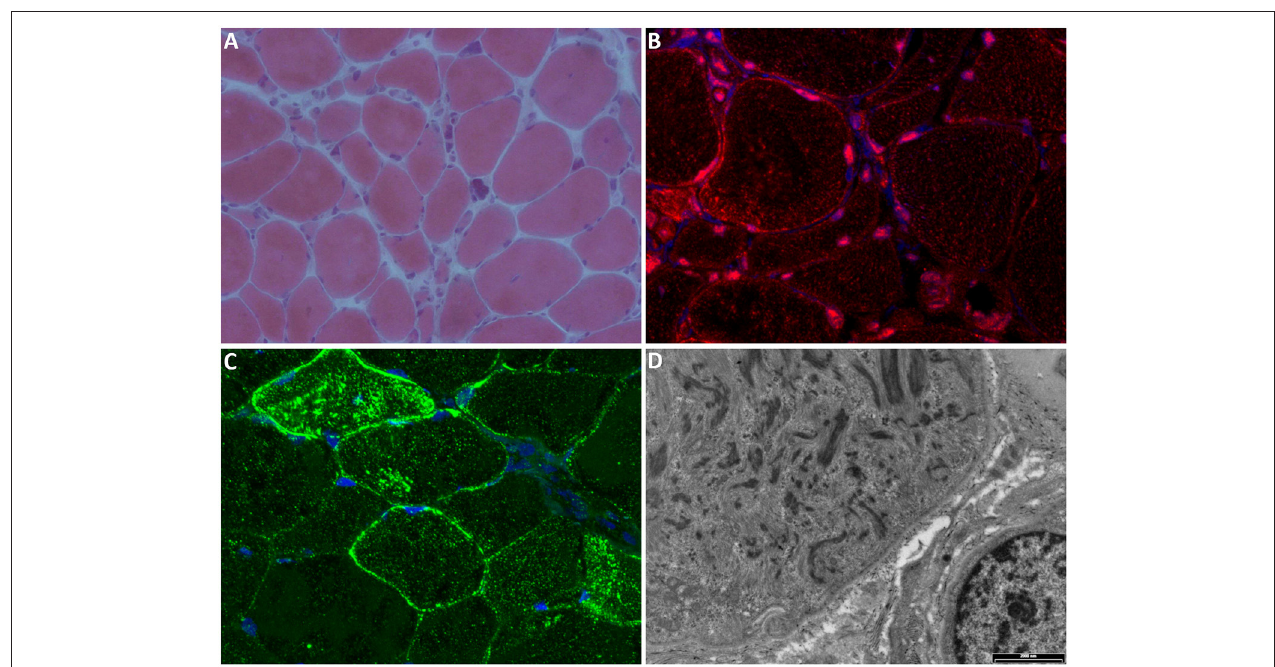
FIGURE 3 | Muscle biopsy. (A) Hematoxylin-eosin stain shows marked fiber atrophy, clusters of pyknotic nuclei, and occasional central nuclei (magnification 20 × ). (B) Immunofluorescence (IF) for TNPO3 (red) shows nuclear/perinuclear and cytoplasmic positivity; nuclei are stained with DAPI (blue); magnification 60 × . (C) IF for SRSF1 (green) shows cytoplasmic and subsarcolemmal aggregates positive for SRSF1; nuclei are stained with DAPI (blue); magnification 60 × . (D) Electron microscopy showing myofibrillar disarray (scale bar: